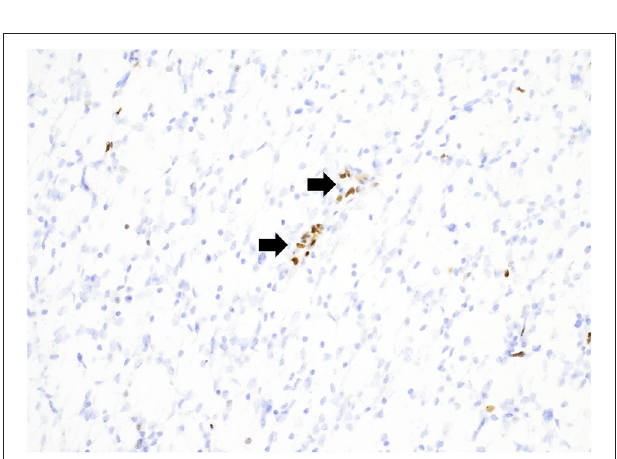
FIGURE 6 | Diffuse midline glioma, H3K27-altered demonstrating a loss of nuclear staining for H3K27me3 with positive endothelial cells serving as an internal control (arrows). H3K27me3 immunostain, 200x